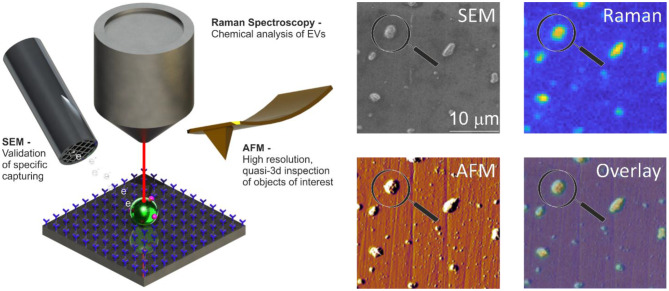
Atomic force microscopy (AFM), scanning electron microscopy (SEM), and Raman spectroscopy of extracellular vesicle (EV) sample. Schematic representation of the system: antibody-functionalized stainless-steel substrate examined with SEM, AFM, and Raman for correlated multimodal analysis of individual EVs. Image adapted from Beekman et al. (15).